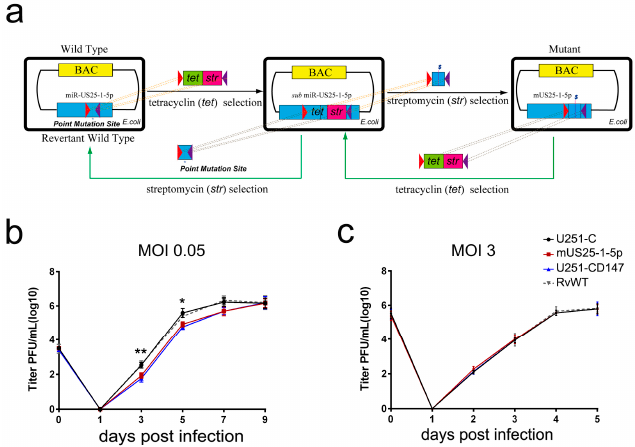
Figure 5. Mutation of miR-US25-1-5p or ectopic expression of CD147 can delay HCMV lytic propagation at low MOI. ( a ) Schematic construction of HCMV mUS25-1-5p and the revertant wild type (RvWT) with bacterial artificial chromosome (BAC) mutagenesis technique. U251 control cells (U251-C) were infected with the HCMV wild-type virus, RvWT or HCMV-mUS25-1-5p mutant virus (mUS25-1-5p) and CD147-overexpressing cells (U251-CD147) were infected with HCMV wild-type virus at an MOI of ( b ) 0.05 or ( c ) 3. Cell-associated and supernatant virus were harvested at the dpi indicated. Titers were determined by plaque assay. The values obtained were averages ± SD from triplicate experiments. * Denotes p < 0.05, ** denotes p <